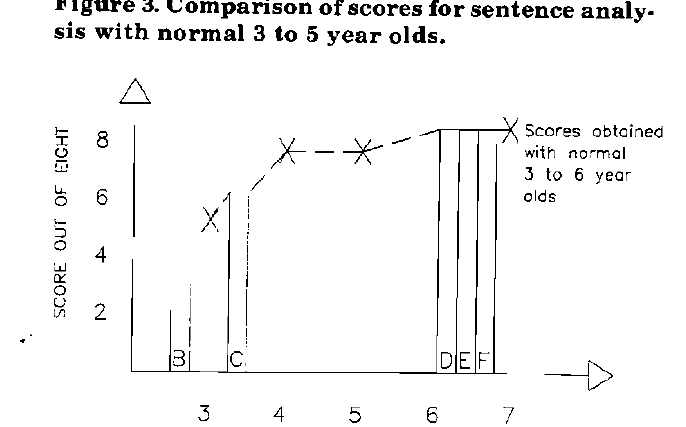
Figure 4. Comparison of scores for word analysis with normal 3 to 6 year